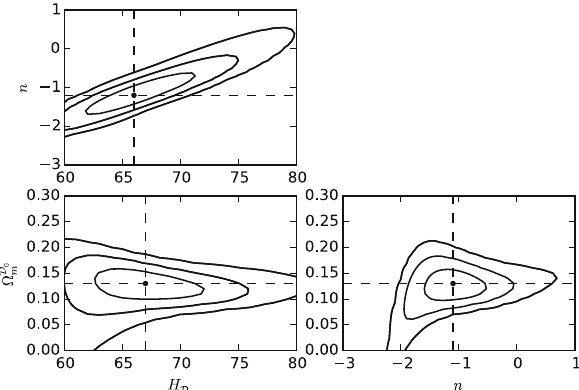
Fig. 6 Same as Fig. 5, but with Gaussian prior of H D